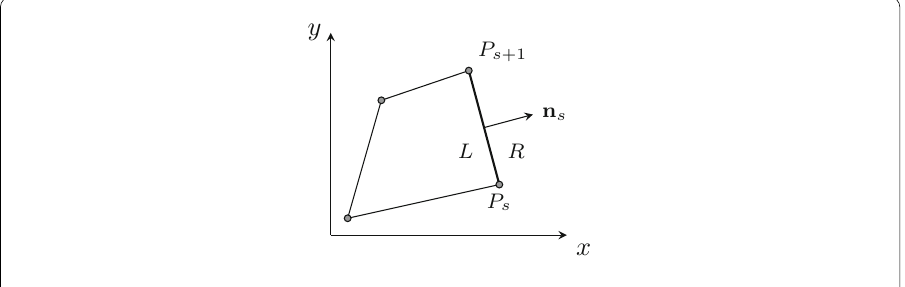
Fig. 1 Quadrangular finite